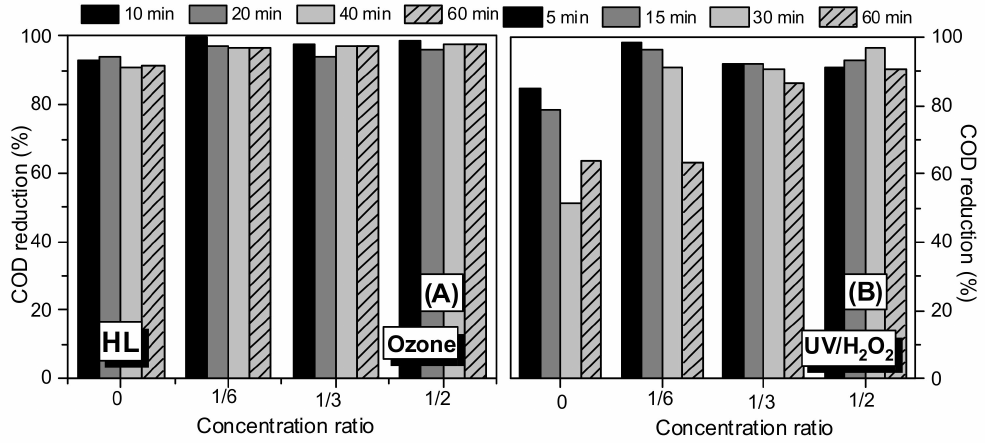
Figure 7. Chemical oxygen demand COD reduction during NF of oxidized TRC solution: ( A ) after ozonation; ( B ) after UV/H 2 O 2